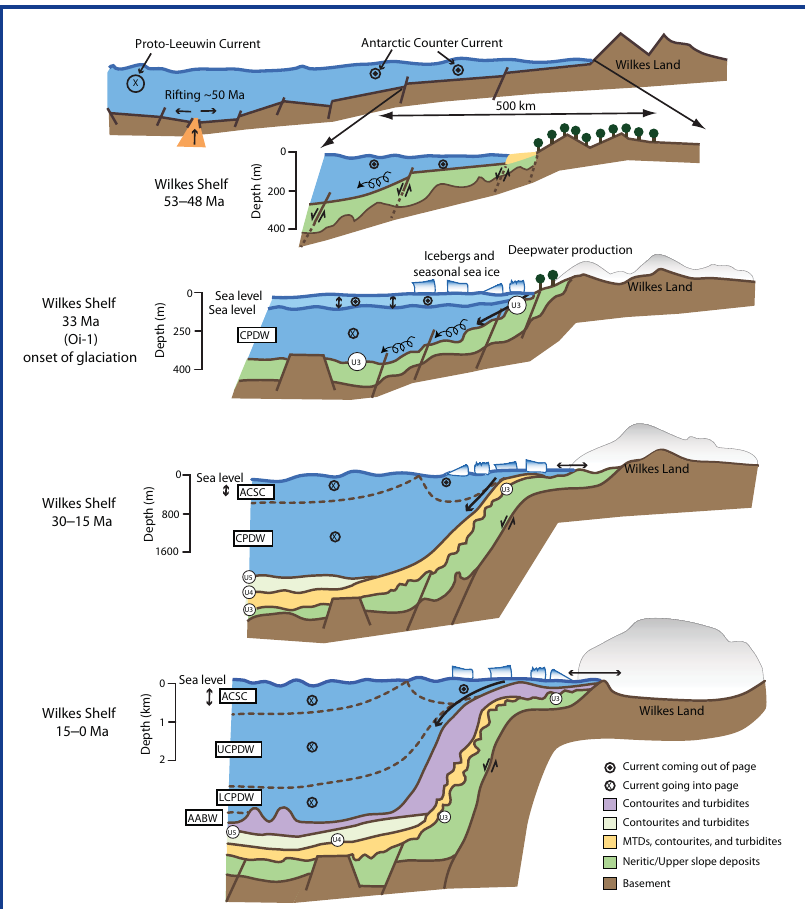
Figure 6. Conceptual illustration of tectonic, geological, sedimentological, and climatic evolution of the Wilkes Land margin since the middle early Eocene (~54 Ma). U3, U4, and U5 refer to seismic unconformities WL-U3, WL-U4, and WL-U5, respectively. Oi-1 = Oligocene isotope Event 1, CPDW = Circumpolar Deep Water, ACSC = Antarctic Circumpolar Surface Water, UCPDW = Upper Circumpolar Deep Water, LCPDW = Lower Circumpolar Deep Water, AABW = Antarctic Bottom Water. MTD = mass transport debris